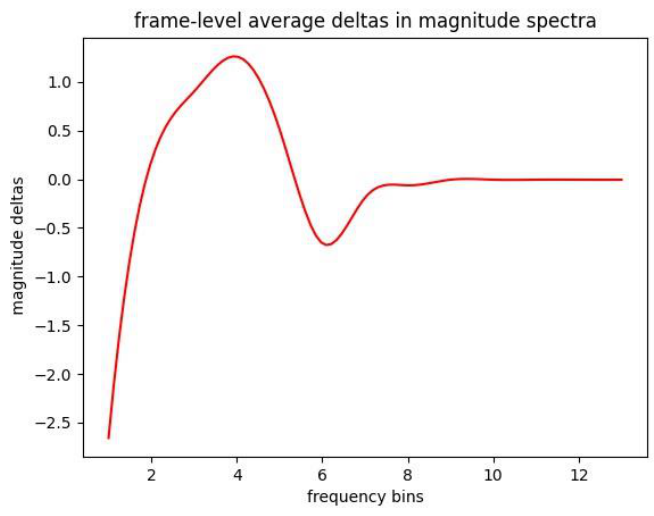
Figure 5. The average spectrum difference between genuine and replayed signals.